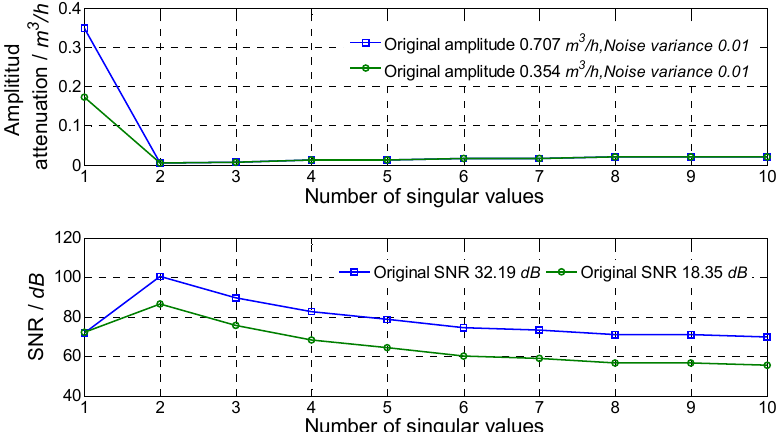
Figure 2. Result of using different numbers of singular values.